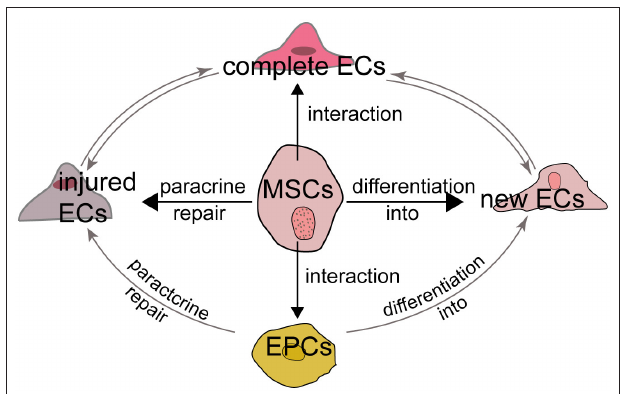
FIGURE 2 | MSCs and endothelial cells The relationship between MSCs and ECs can be summarized as follows. First, MSCs can repair the injured but not dead ECs through their paracrine function to induce the release of growth factors. Second, MSCs have the potential to differentiate into new ECs although it is controversial. Third, the interaction and crosstalk between MSCs and existing ECs promotes the formation of new ECs and the repair of injured ECs. Last, MSCs also interact with EPCs to influence EC formation and